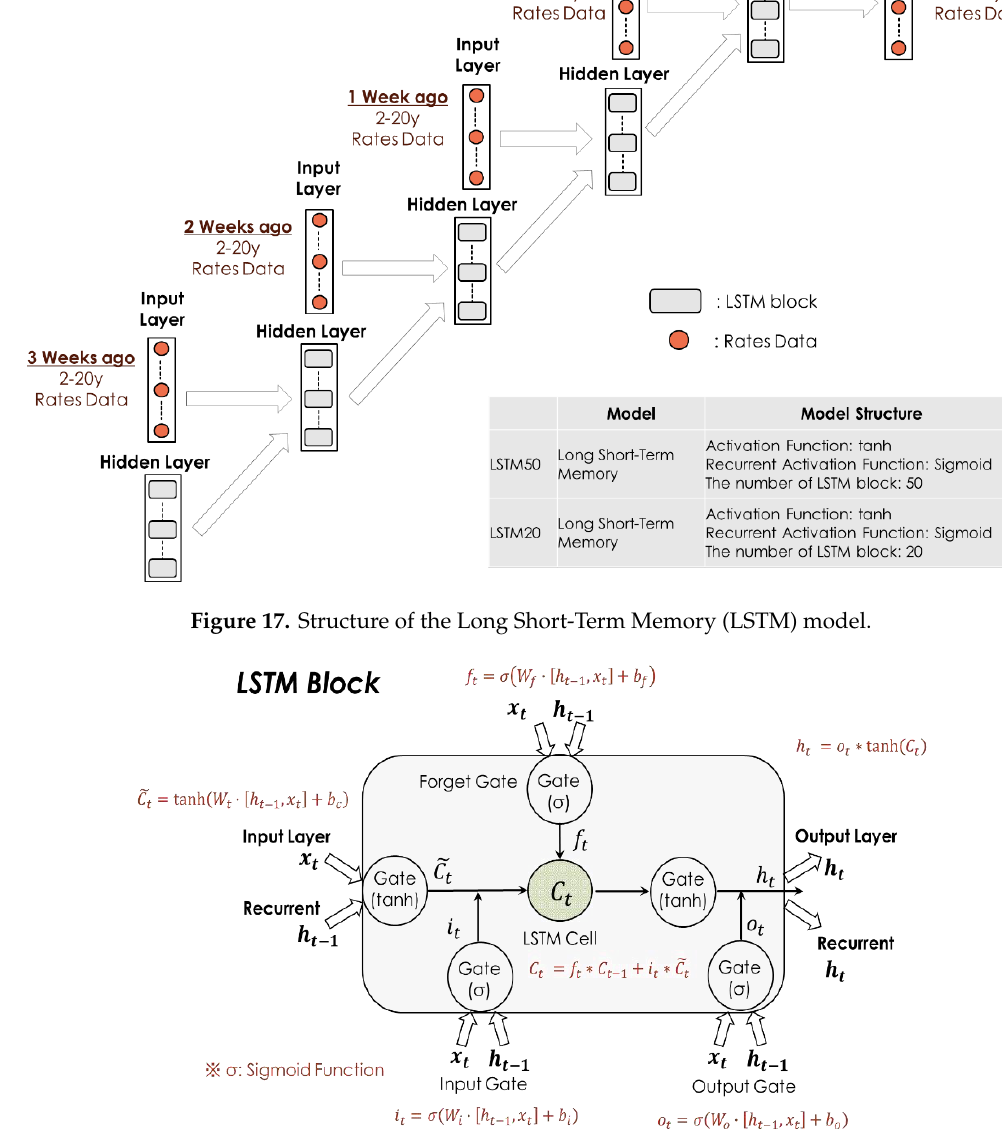
Figure 18. Structure of the LSTM block.